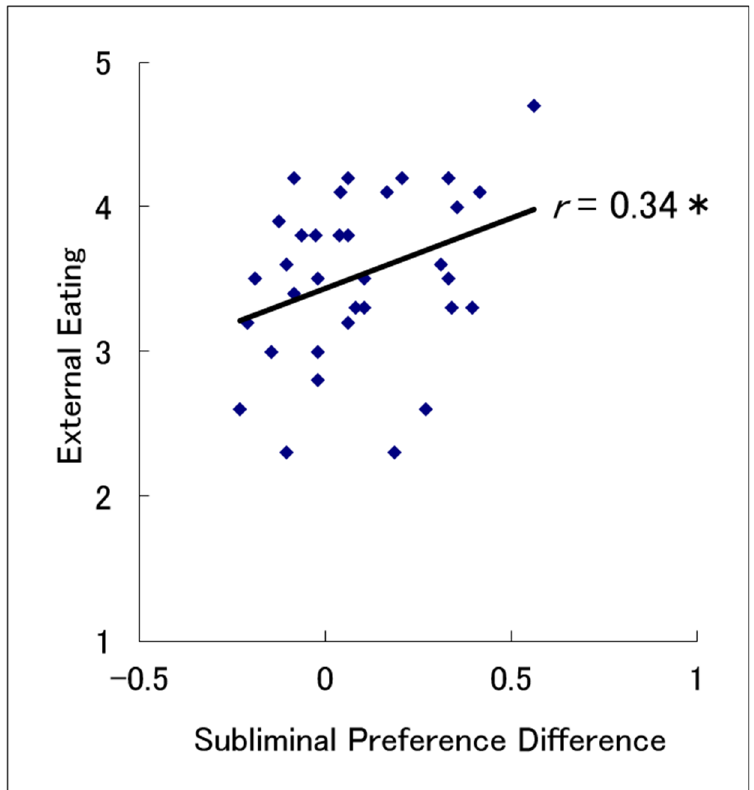
Fig 3. A scatter plot with regression lines of food preference scores under the subliminal condition as a function of external eating